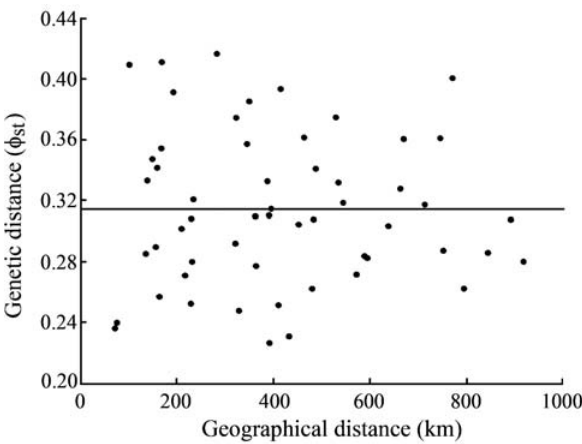
Figure 5 - Graphical representation of the Mantel test results between the geographic and genetic distances for Eupemphix nattereri populations in central